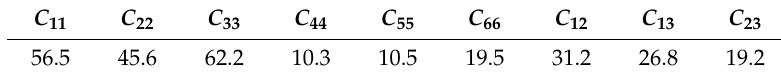
Table 1. Calculated elastic constants C ij for UI 3